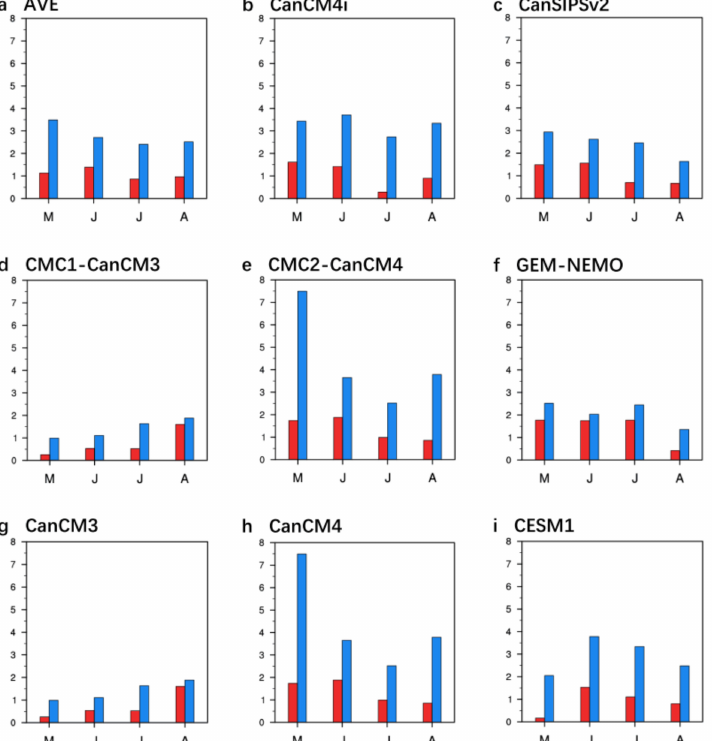
Figure 5. Signal-to-noise ratios (SNR) of zonal wind anomalies at 850 hPa averaged over western equatorial Atlantic (3 ◦ S–3 ◦ N, 40 ◦ W–20 ◦ W) for ( a ) the average of eight models, and ( b – i ) the individual models. The SNR are derived from 3-month-lead forecasts, and the target months of May, June, July and August are chosen for verification, respectively. Red (blue) bars are for the selected Atlantic Niño (Atlantic Niña)